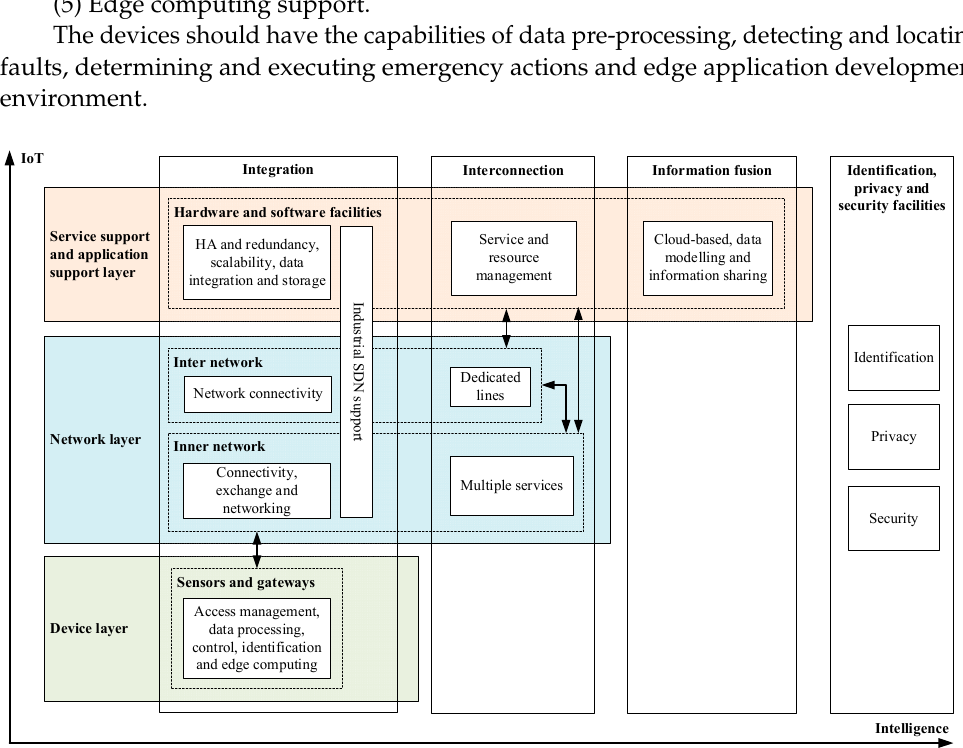
Figure 2. Reference framework of the capabilities of IIoT infrastructure for